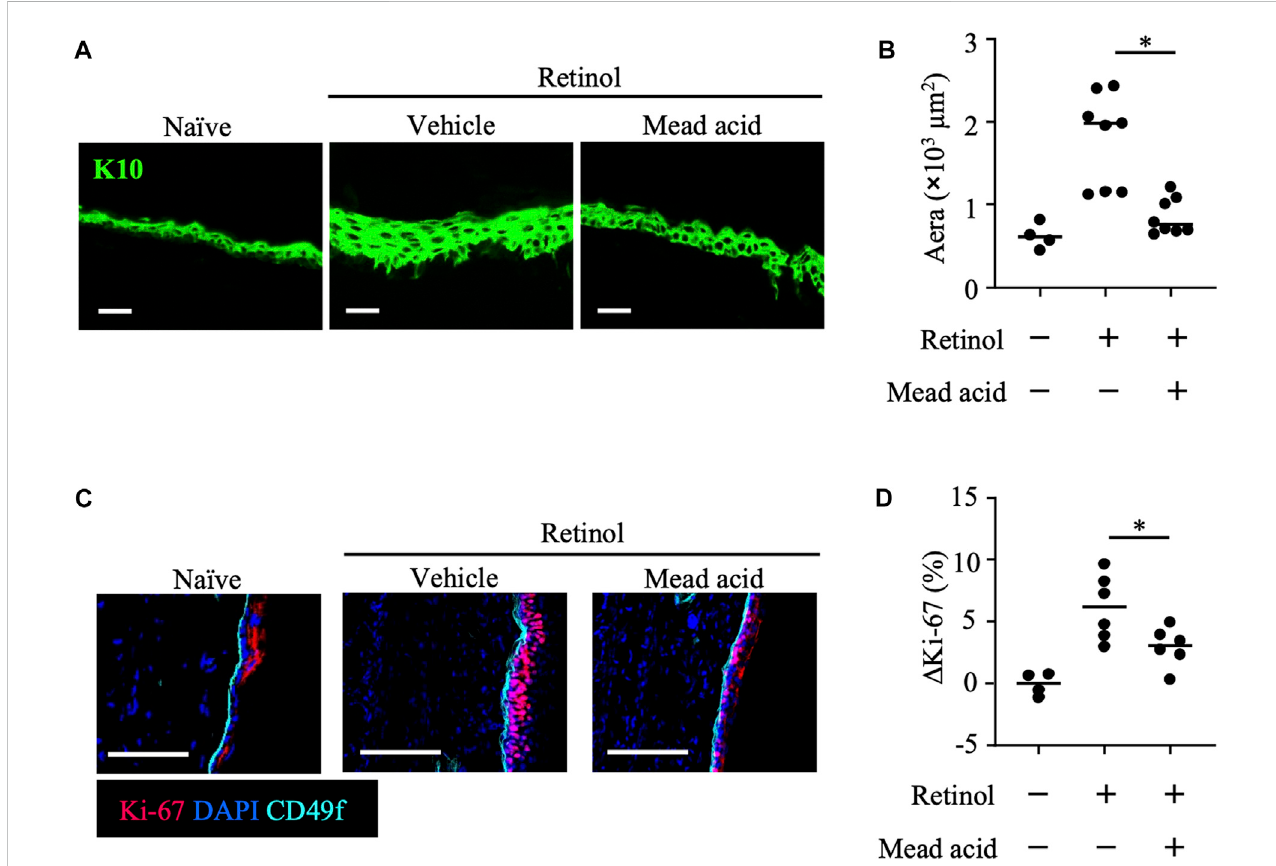
Mead acid inhibits keratinocyte abnormalities induced by retinol. Retinol was applied topically for 4 consecutive days to induce ICD. Mice were treated topically with vehicle or mead acid after retinol treatment. (A) Frozen ear sections obtained on day 4 were stained with anti-K10 antibody. Scale bars, 20 μ m. Representative images from three independent experiments are shown. (B) The area stained for K10 was calculated by using BZ-X700 Analyzer software. (C) Frozenearsectionswerestainedwiththeindicatedantibodies. Representativeimagesfrom two independentexperimentsare shown. Bars, 100 μ m. (D) The percentage of Ki-67-expressing keratinocytes gated as CD45 − CD31 − CD34 − CD49f + was measured by fl ow cytometry. The rate of increase of Ki-67 + cells [ Δ Ki-67 (%)] was calculated as (Ki-67 [%]) — (Ki-67 [%] average in retinol-untreated mice) on day 4. Data are combined from four independent experiments. Horizontal bars indicate median values. * p <